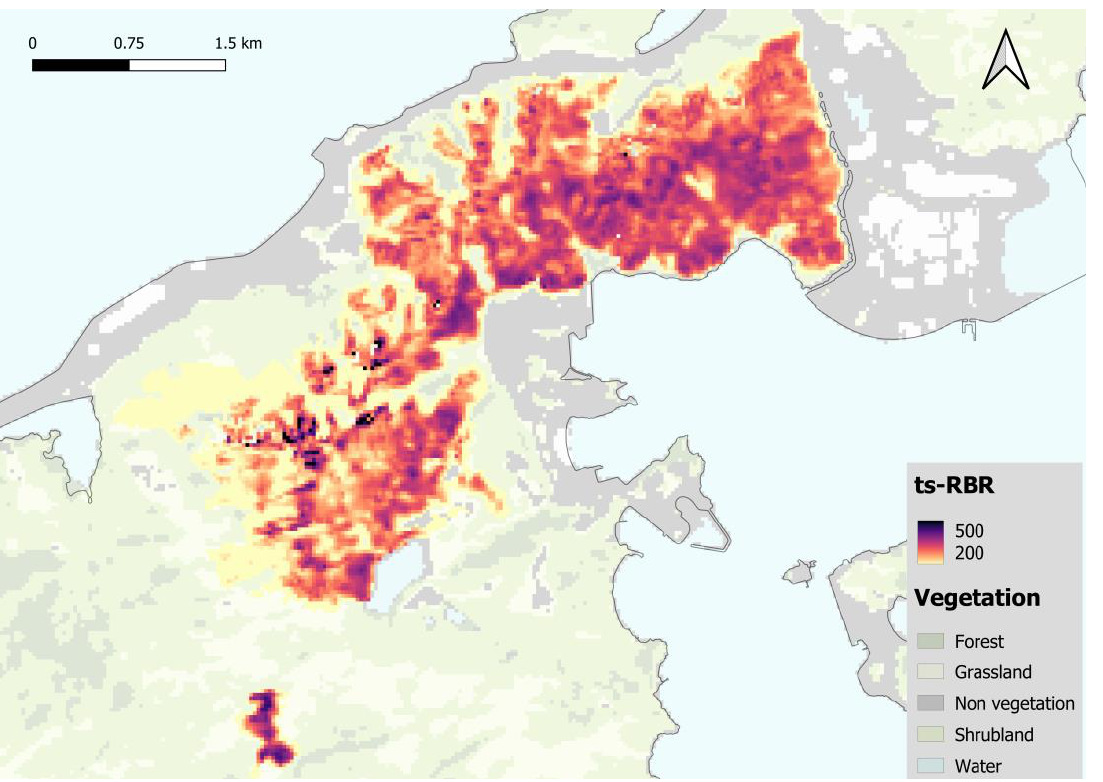
Figure 11. Burn severity estimated by time series relativized burn ratio (ts-RBR) of two fires near Discovery Bay, Lantau Island (22°1 8′ 35.19 ″ N, 114° 0′ 25.95 ″ E) in 2004. The background map is a Landsat-based vegetation map of the area in the same year (Chan et al. unpublished manuscript).